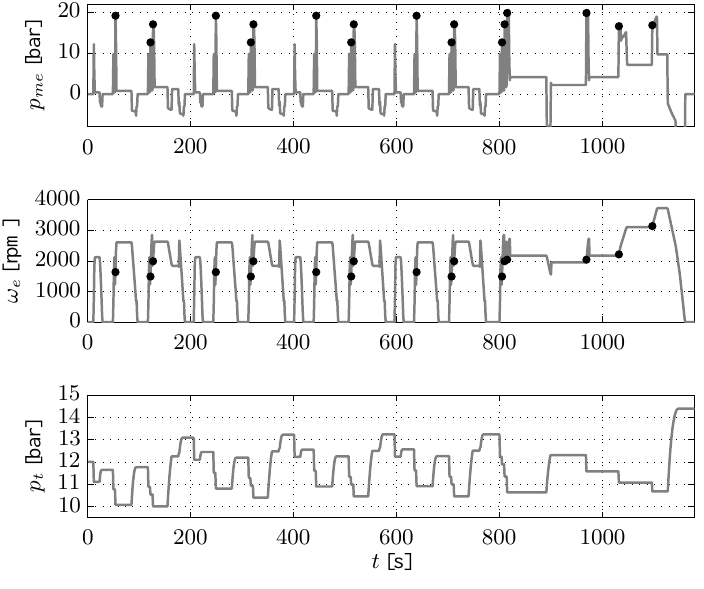
Figure 7. Mean effective pressure p the aNEDC drive cycle. The black dots indicate